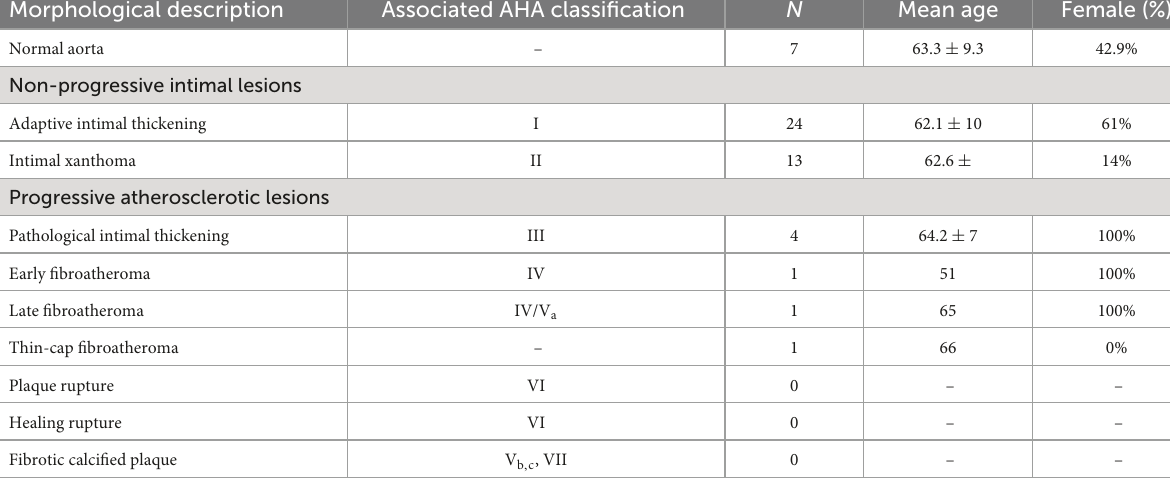
TABLE 1 Atherosclerotic lesions in type A aortic dissection